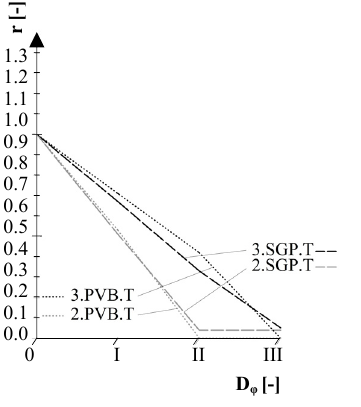
Figure 24: Relative redundancy curves for all glass beams presented in this